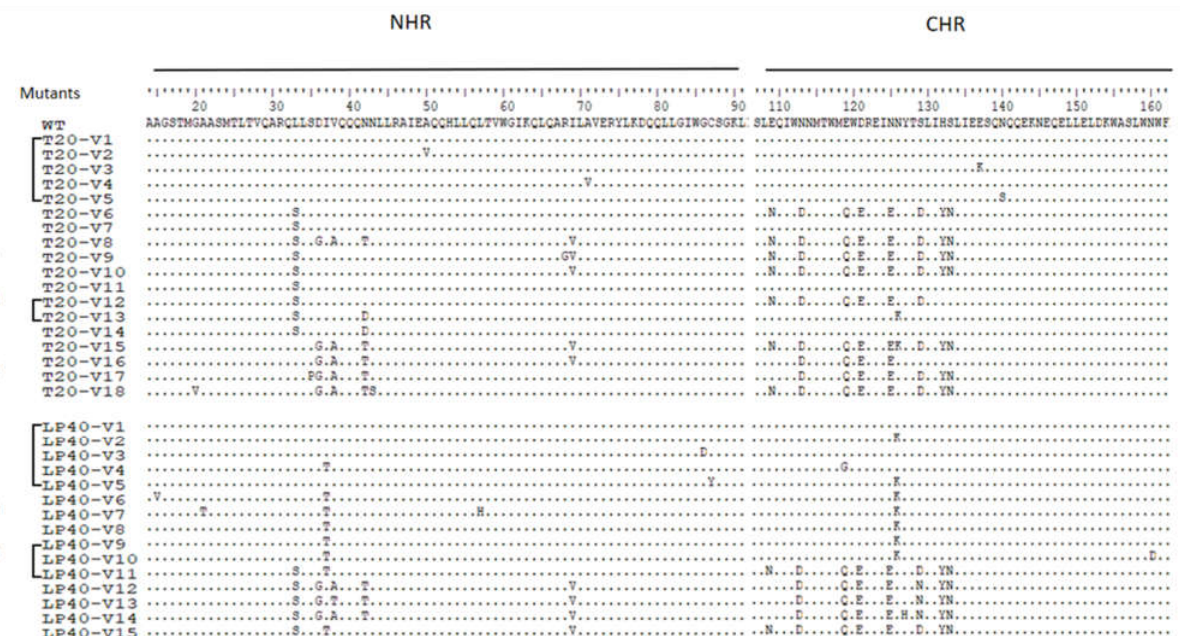
Figure 2. Introduction of T20- and LP40-resistant HIV-1. ( A ) The dose-escalating selections were conducted for a total of 32 passages, with T20 concentrations ranging from 500 nM to 2000 µM, and ( B ) for 32 passages, with LP40 concentrations ranging from 40 nM to 200 µM. At the indicated passage number, viral RNA was extracted from the supernatant, and gp41- and gp120-coding regions were sequenced. The mutations of gp41 are listed in the black frames. ( C ) HIV-1 NL4-3 was passaged in the presence of an increasing concentration of the inhibitors in C8166 cells.